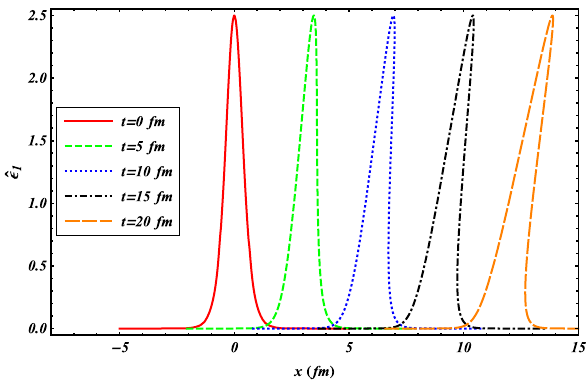
Fig. 1 Evolution of the energy density perturbation with time t and space coordinate x . A = 2 . 5, B = 0 . 5 f m , q = 1 . 08, and T = 140 MeV